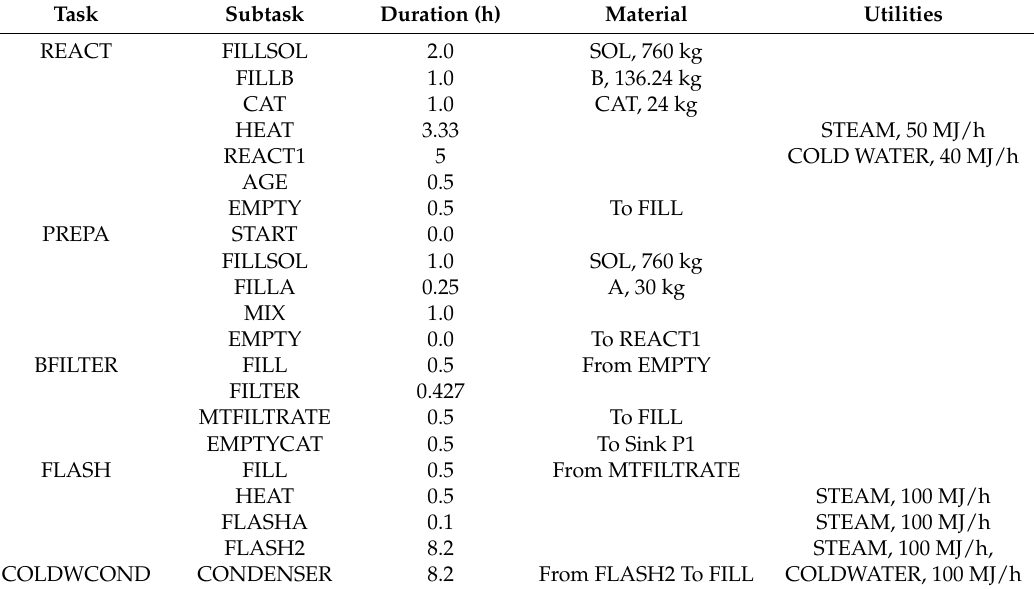
Table 1. Details of the recipe for P1.